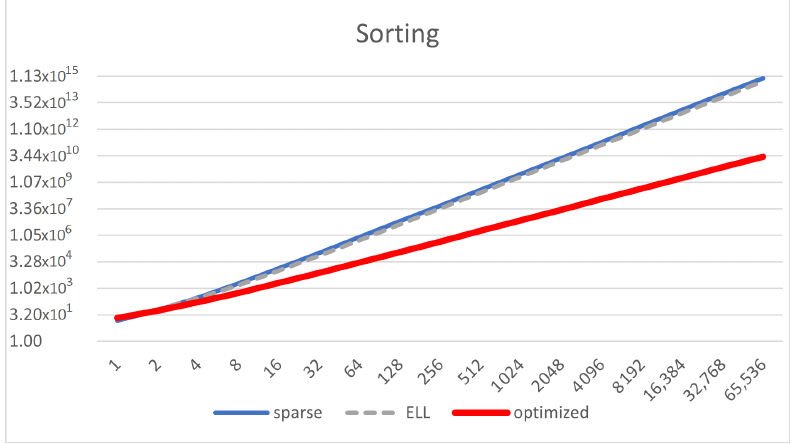
Figure 9. Memory size of the matrix representation (Y-axis in log scale) depending on the amount of natural numbers ( n , X-axis in log scale) for the model of natural number sorting, using sparse, ELL, and optimized representation, for 1 ≤ n ≤ 65536.